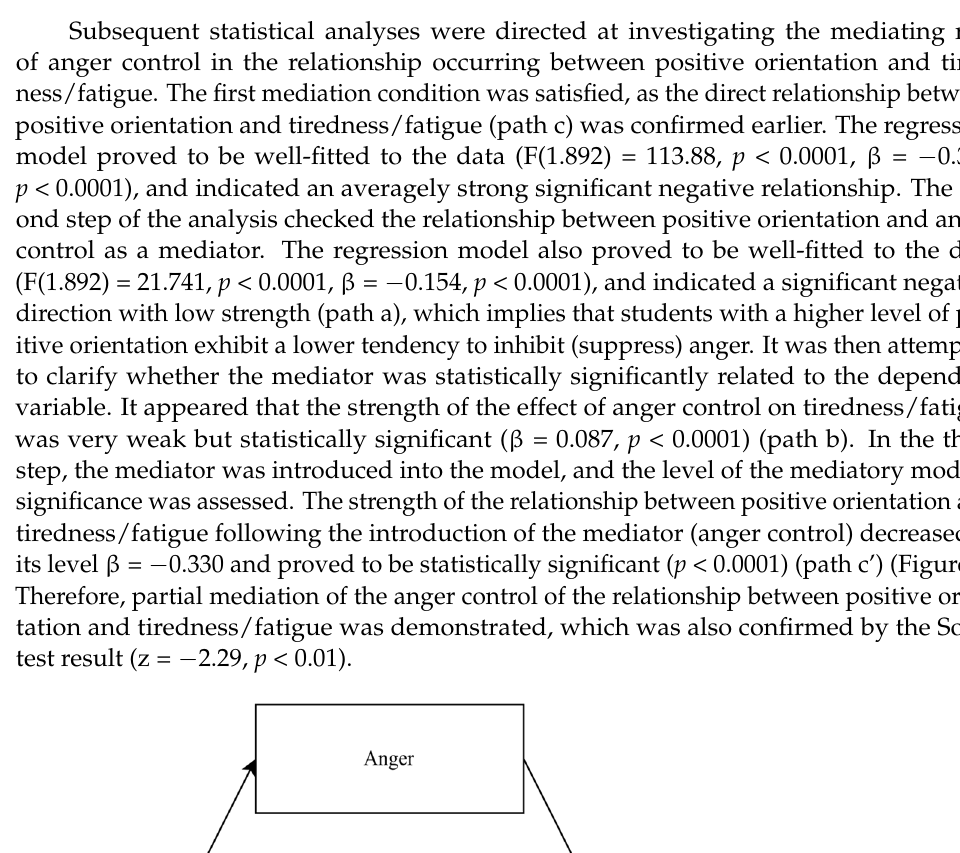
Figure 3. A relationship diagram in the model testing the mediatory effect of emotional control in the general dimension of the relationship between positive orientation and the degree of tiredness/fatigue. Statistically significant: *** p < 0.001. Explanation: SOP—positive orientation, FSS—fatigue severity scale, CECS—emotional control scale.